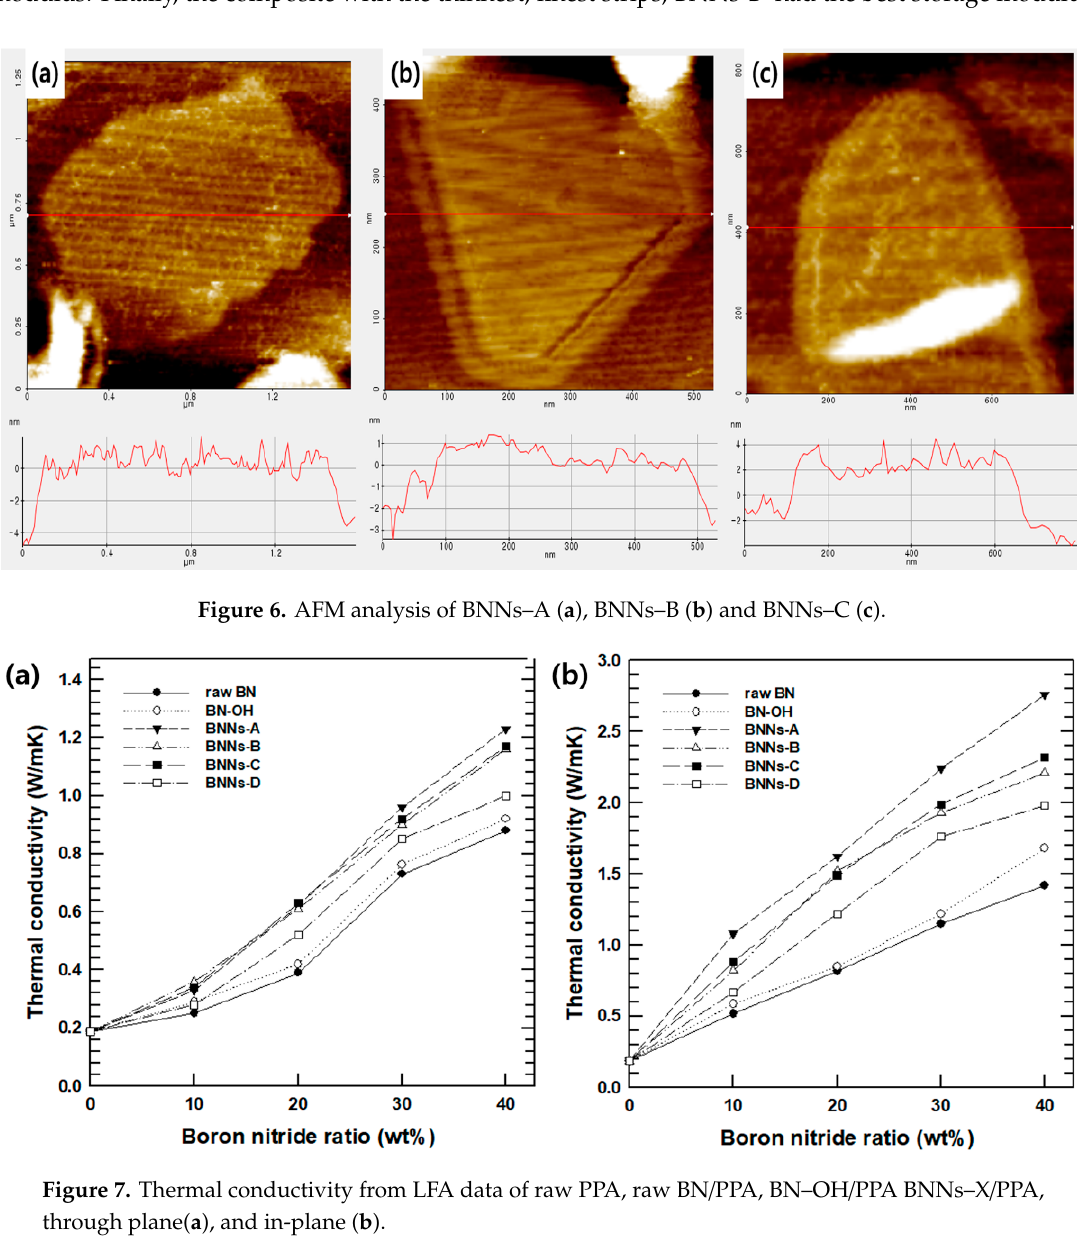
Figure 5. High-resolution transmission electron microscopy (HR-TEM) image of BNNs–A particles ( a – b ), BNNs–B particles ( c – d ) and BNNs–C particles ( e – f ).